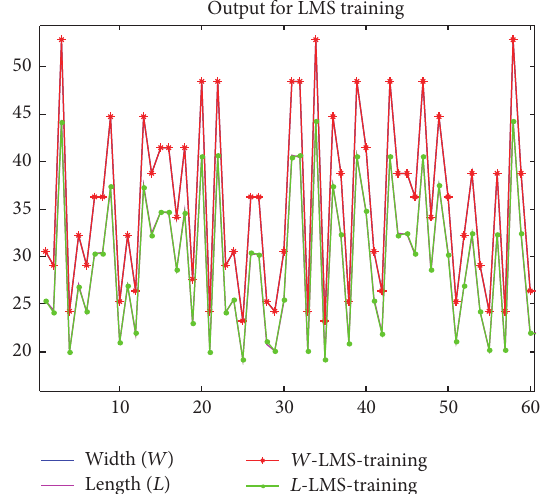
Figure 4: Training results for LMS algorithm.